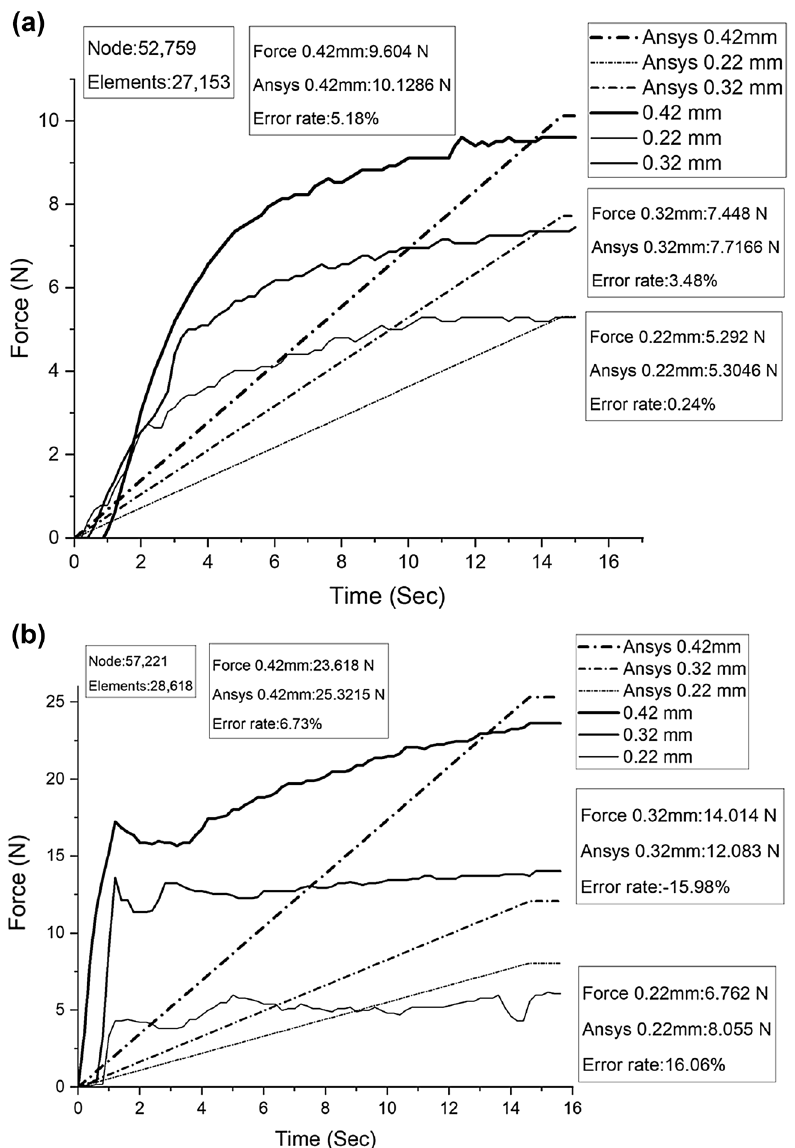
Fig. 7 Comparison of the actuator driving force between the finite elements analysis model and experimental data of the shape memory textile actuator for diameters: 0.3 mm ( a ) and 0.5 mm ( b